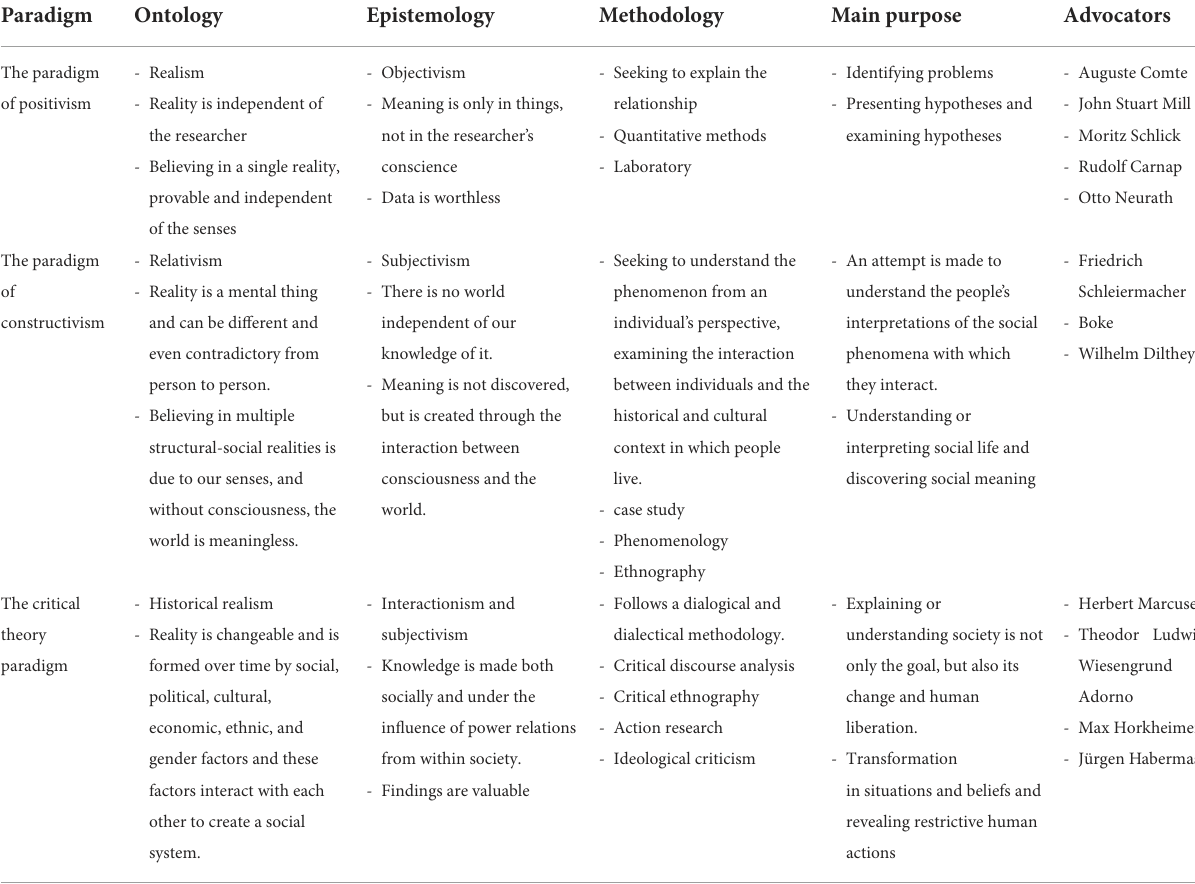
TABLE 1 Comparison of the positivism, constructivism and critical theory paradigms.